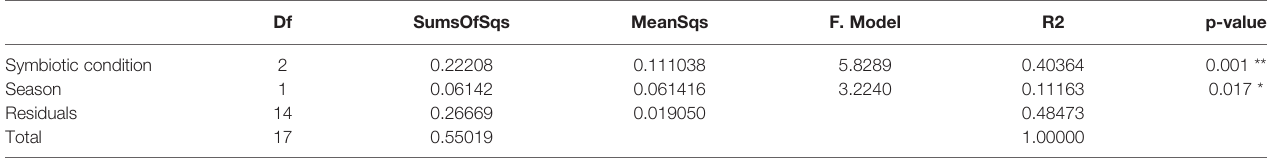
TABLE 2 | PERMANOVA covariate analysis based on nMDS dissimilarities of the phylogenetic distance of matrix data of the bacterial community of SML by symbiotic condition (control, bleached) and season (summer, winter).